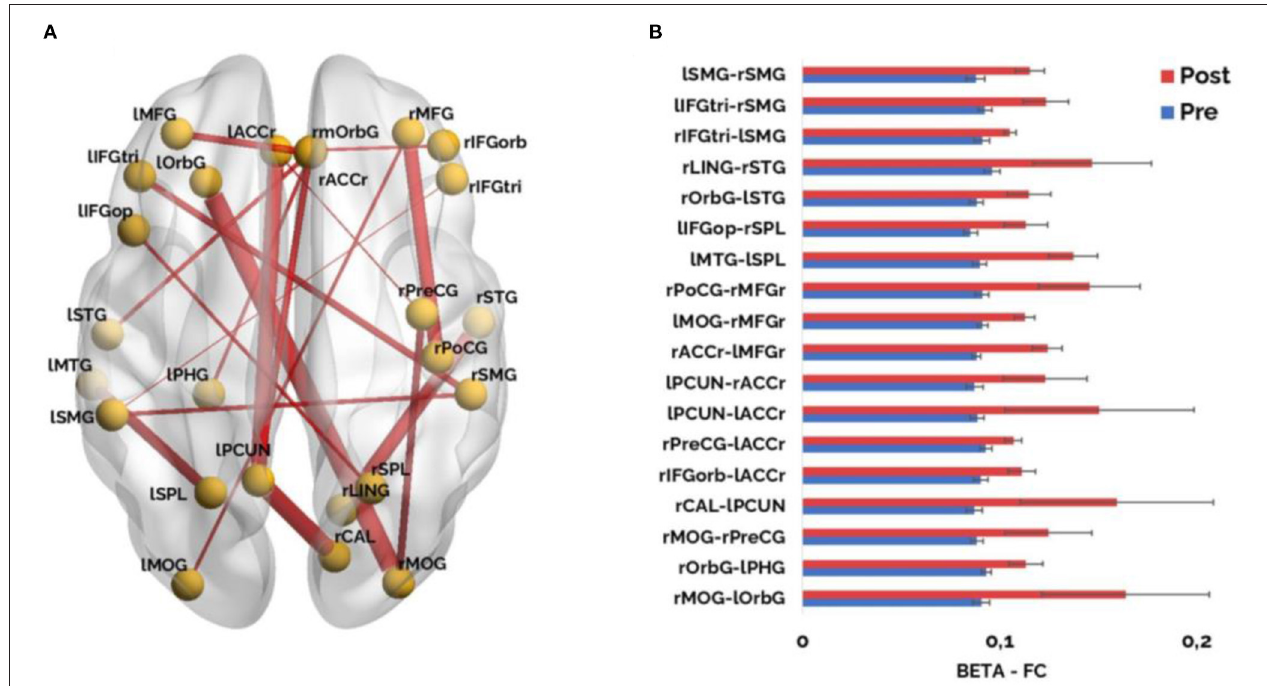
FIGURE 4 | (A) Significant FC results ( p < 0.005, corrected) in the beta band (12–30Hz) when comparing within the stroke patients’ group, the pre-condition and the post- condition. Line thickness of significant links is proportional to FC values (a higher value corresponds to thicker lines, and vice versa); (B) Significant functional connectivity links in the beta band are represented as bar graphs. Red color represents higher connectivity values for pre-condition compared to post-condition and blue color illustrates lower connectivity values for pre-condition compared to post-condition. ROIs included: lMFG, Left Middle Frontal Gyrus; rMFG, Right Middle Frontal Gyrus; lIFG, Left Inferior Frontal Parstriangularis; rIFG, Right Inferior Frontal Parstriangularis; rmOrbG, Right Medial Orbito Frontal Gyrus; lACCr, Left Rostral Anterior Cingulate; rACCr, Right Rostral Anterior Cingulate; lOrbG, Left Lateral Orbito Frontal Gyrus; rIFGorb, Right Inferior Frontal Orbital; lIFGop, Left Inferior Frontal Gyrus Opercular; lSTG, Left Superior Temporal Gyrus; rPreCG, Right Precentral Gyrus; rSTG, Right Superior Temporal Gyrus; lMTG, Left Middle Temporal Gyrus; rPoCG, Right Poscentral Gyrus; lPHG, Left Parahipocampal Gyrus; rSMG, Right Supramarginal Gyrus; lSMG, Left Supramarginal Gyrus; lPCUN, Left Precuneus; lstroke patientsL, Left Superior Parietal Lobule; rstroke patientsL, Right Superior Parietal Lobule; rLING, Right Lingual Cortex; rCAL, Right Calcarine; lMOG, Left Lateral Occipital Gyrus; rMOG, Right Lateral Occipital